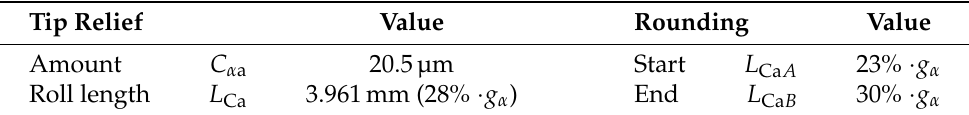
Table 2. Parameters of the linear tip relief with parabolic